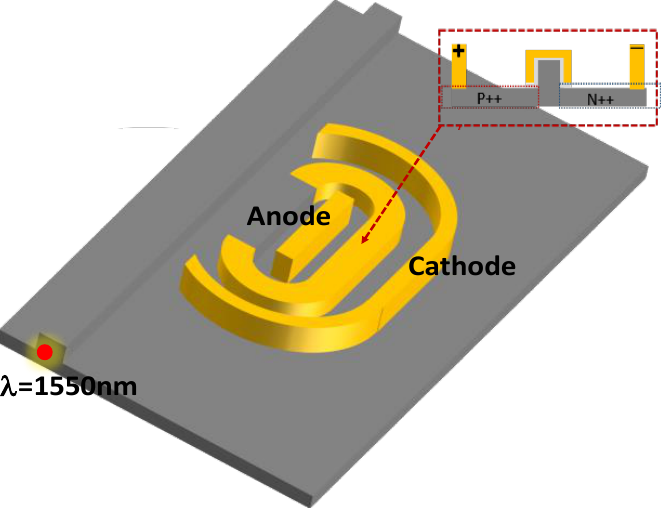
Figure 1. Schematic drawing of the carrier-injection plasmonic micro-ring modulator (CIPMRM).